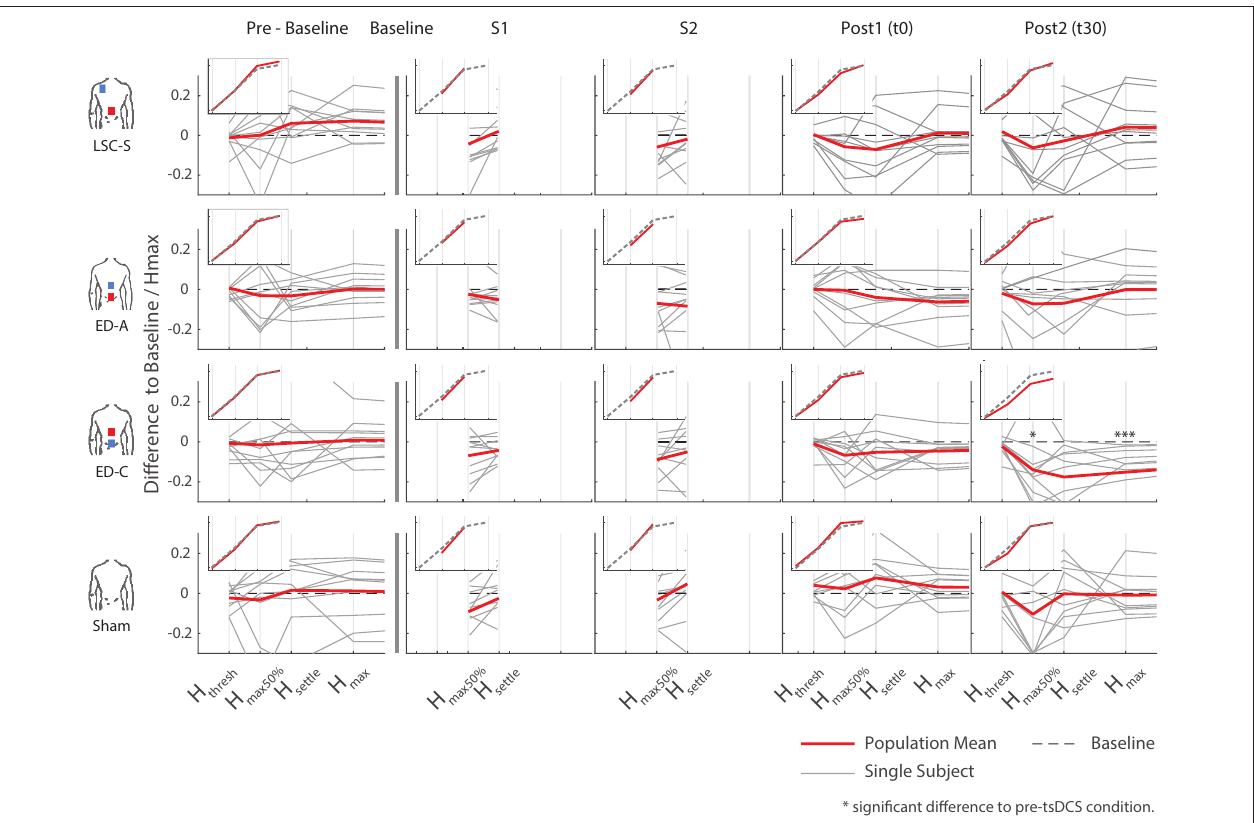
FIGURE 5 | Overview of all differences to baseline, as a percentage of the corresponding H max at baseline, for all configurations and measurements. The inlays show the average trend over all subjects with respect to a generic s-function representing baseline. Significant differences with respect to pre-intervention measurements arose for configuration ED-C, 30min after intervention (last